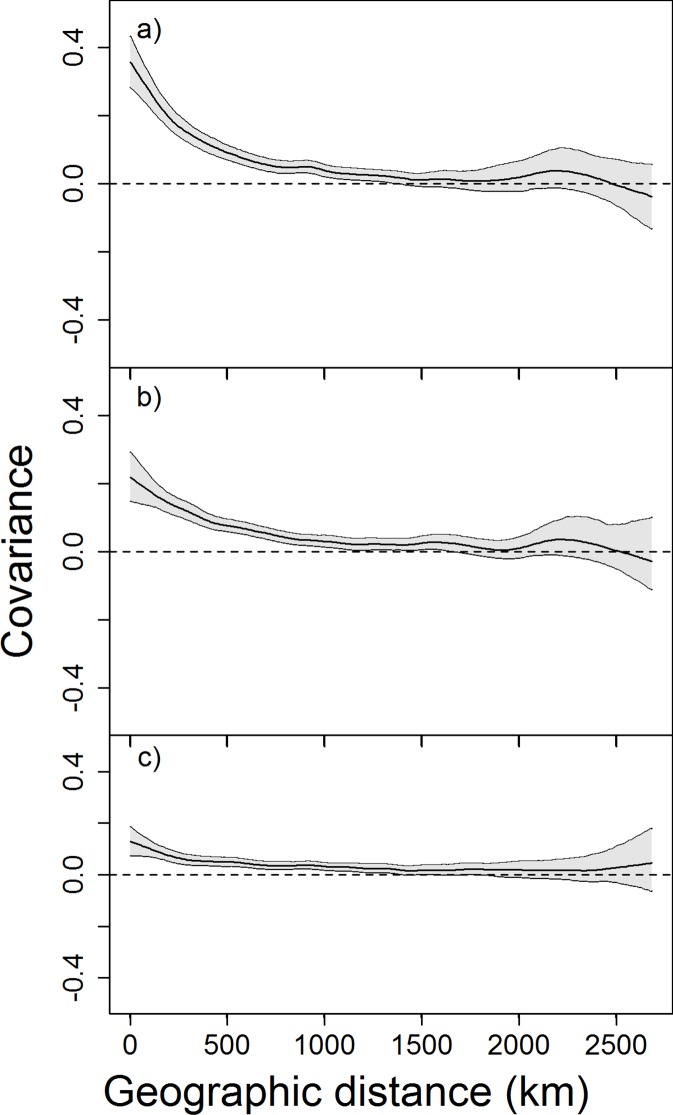
Spline correlograms illustrating the non-parametric spatial covariance function and 95% confidence intervals (gray area) for (a) large fire occurrence; (b) fire size; and (c) percent of high severity burning.